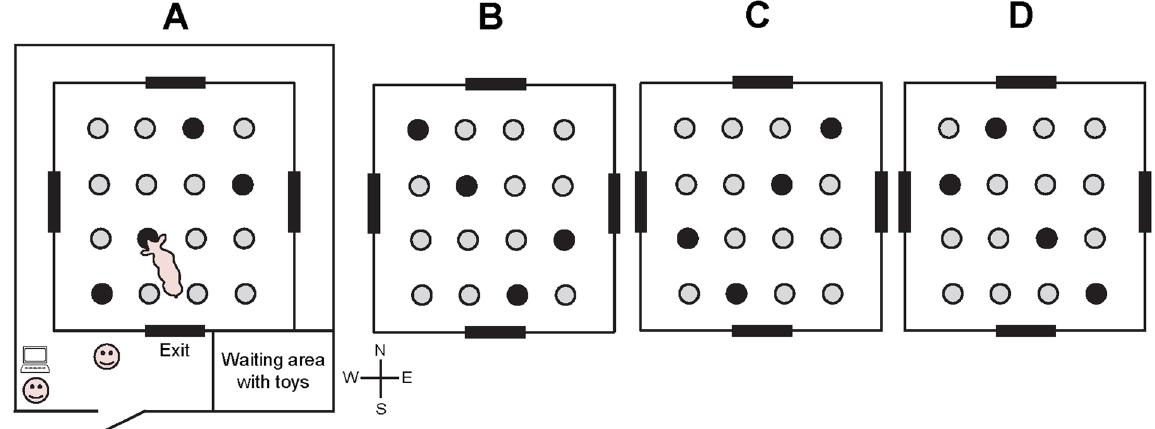
Figure 2. Schematic of the testing room and the four configurations of baited buckets for the holeboard task. Piglets were assigned to a fixed configuration of baited buckets during the acquisition phase, and to another configuration during the reversal phase ( A to C , B to D , C to A and D to B